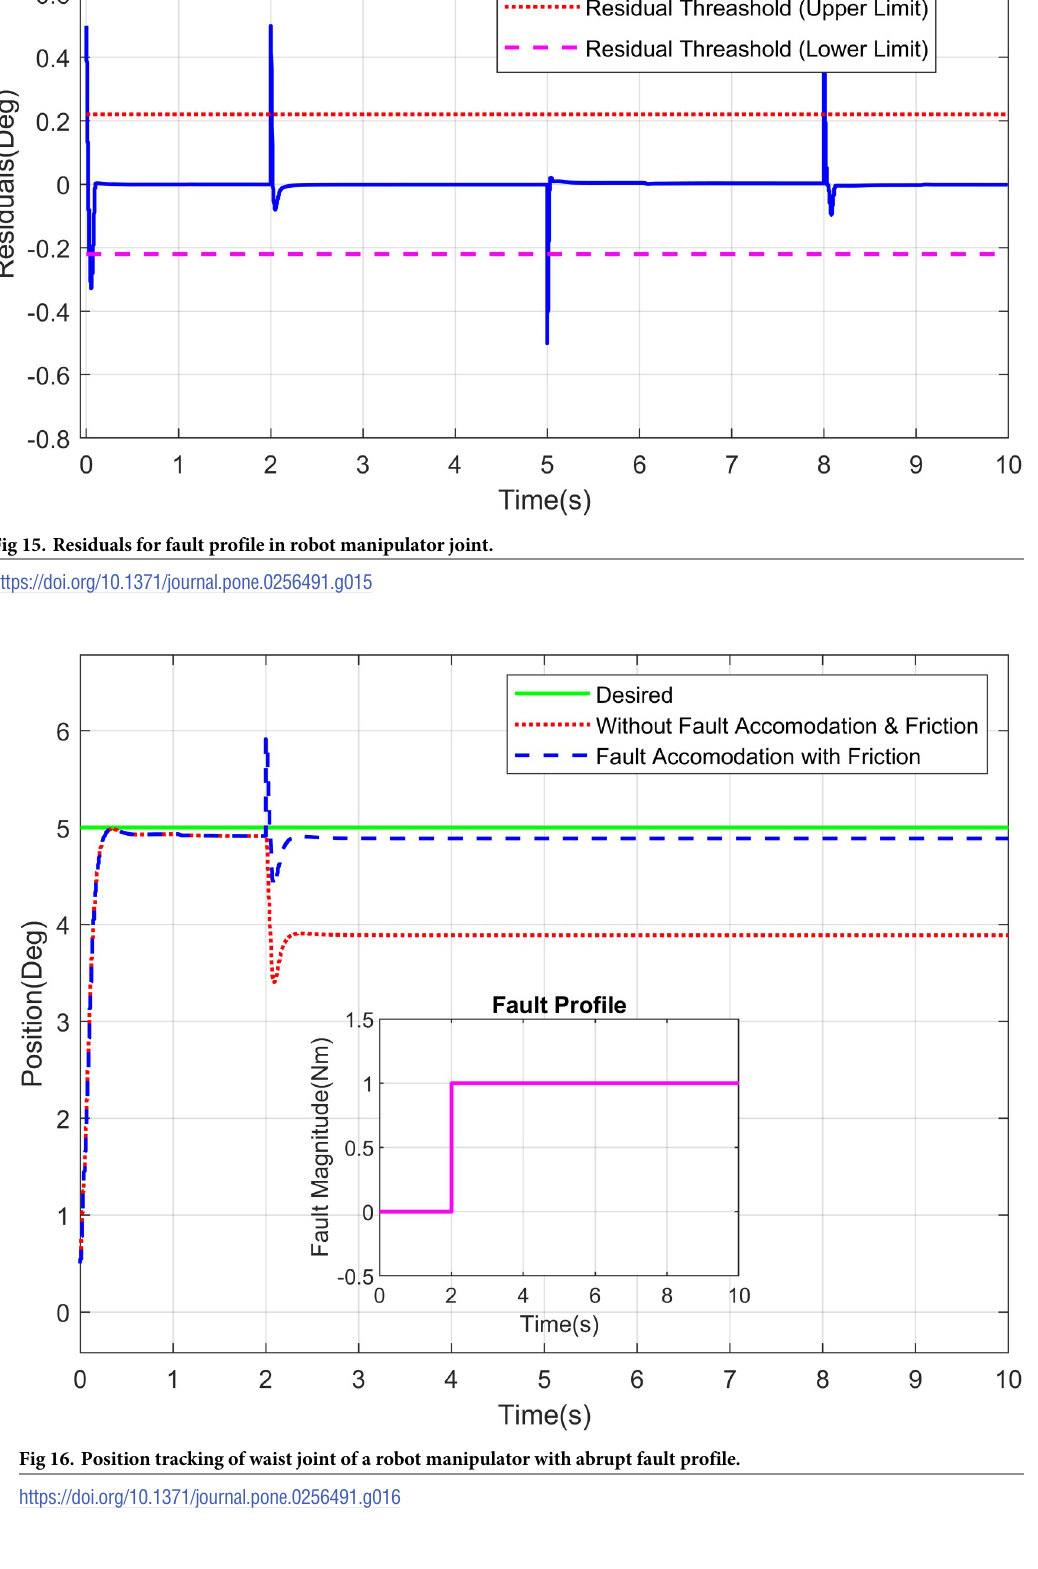
PLOS ONE | https://doi.org/10.1371/journal.pone.0256491 August 20,